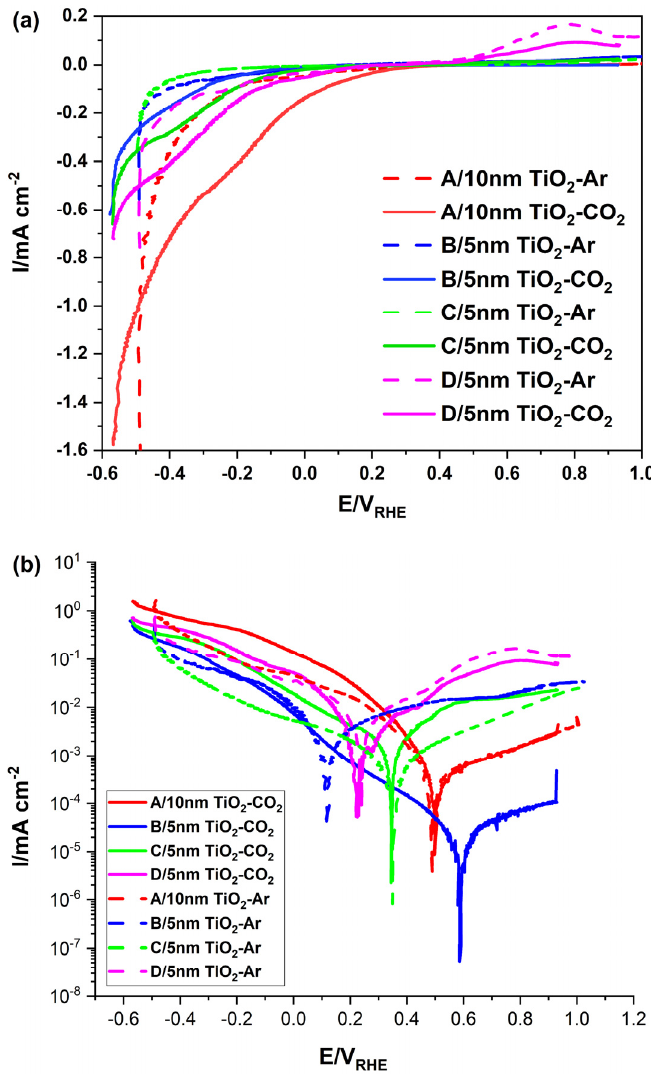
Figure 6. Photocatalytic current − potential curves of p ‐ GaP photocathodes with TiO 2 in a 0.5 M NaCl and 10 mM pyridine solution saturated with Ar or CO 2 measured under AM1.5 irradiance and plot ‐ ted in ( a ) linear and ( b ) semi ‐ log scale. Potential replotted with respect to reference hydrogen elec ‐ trode (RHE). Onset potentials of p ‐ GaP photocathodes are revealed in ( b ). TiO 2 deposited by ALD tends to have n ‐ type doping because of oxygen vacancies [54], which creates a pn ‐ junction in TiO 2 /p ‐ GaP photocathode. It was observed that the onset overpotential could be shifted by the depletion width in pn ‐ junction determined by the varied thickness of TiO 2 , and 10 nm TiO 2 could be the optimum thickness, since the insulating property of thicker TiO 2 will degrade its charge transfer property [17]. The high photocurrent observed in sample A could be due to thicker depletion layer in p ‐ GaP caused by the lower doping concentration, which will increase the width of built ‐ in elec ‐ tric field to enhance the efficiency of collecting photocarriers. An important aspect to con ‐ sider during CO 2 RR is the competitive hydrogen production reaction. As shown in Figure 6a, a significantly enhanced current density in the CO 2 ‐ saturated solution, compared to the Ar ‐ saturated electrolyte, can be observed. This additional current density is generated from the direct CO 2 RR of the dissolved CO 2 [55,56]. Since HER and CO 2 RR are competing reactions, the CO 2 in the electrolyte will occupy the active site and inhibit hydrogen pro ‐ duction to a certain extent. The obvious increment in reduction current can provide evi ‐